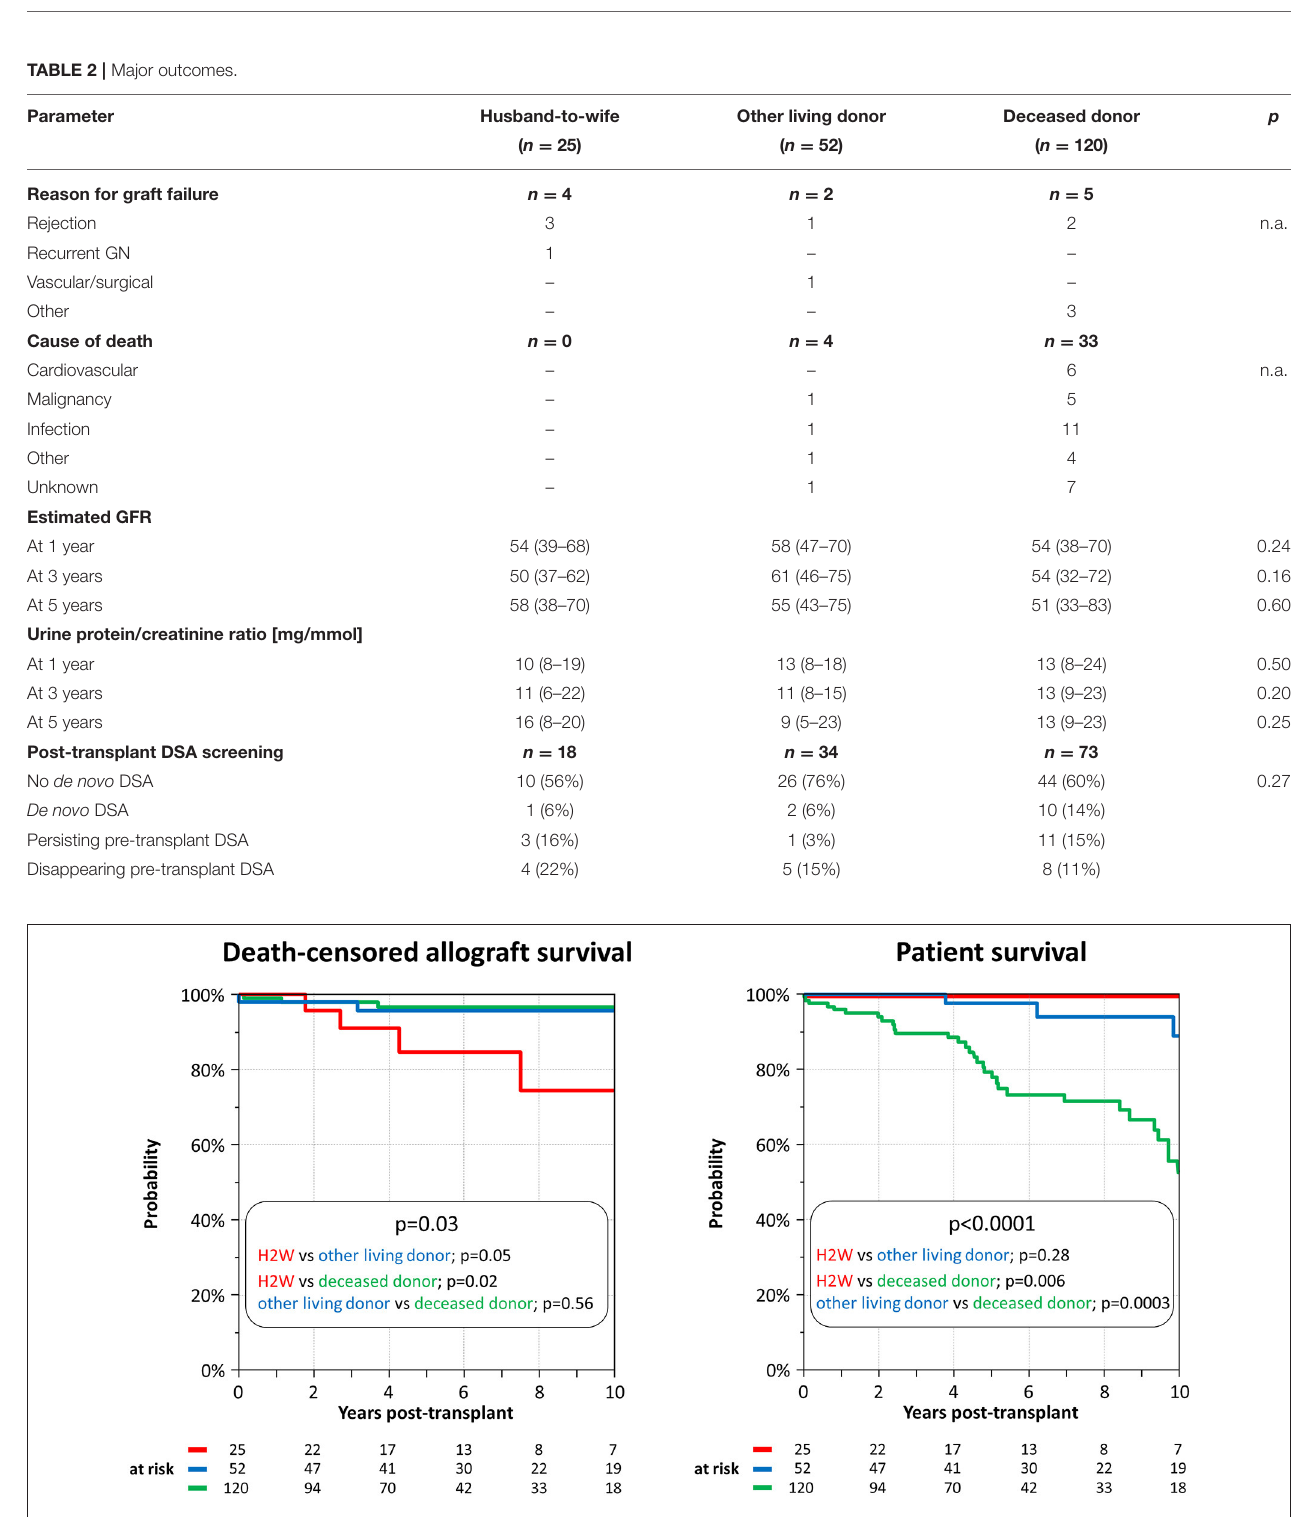
FIGURE 1 | Death-censored allograft and patient